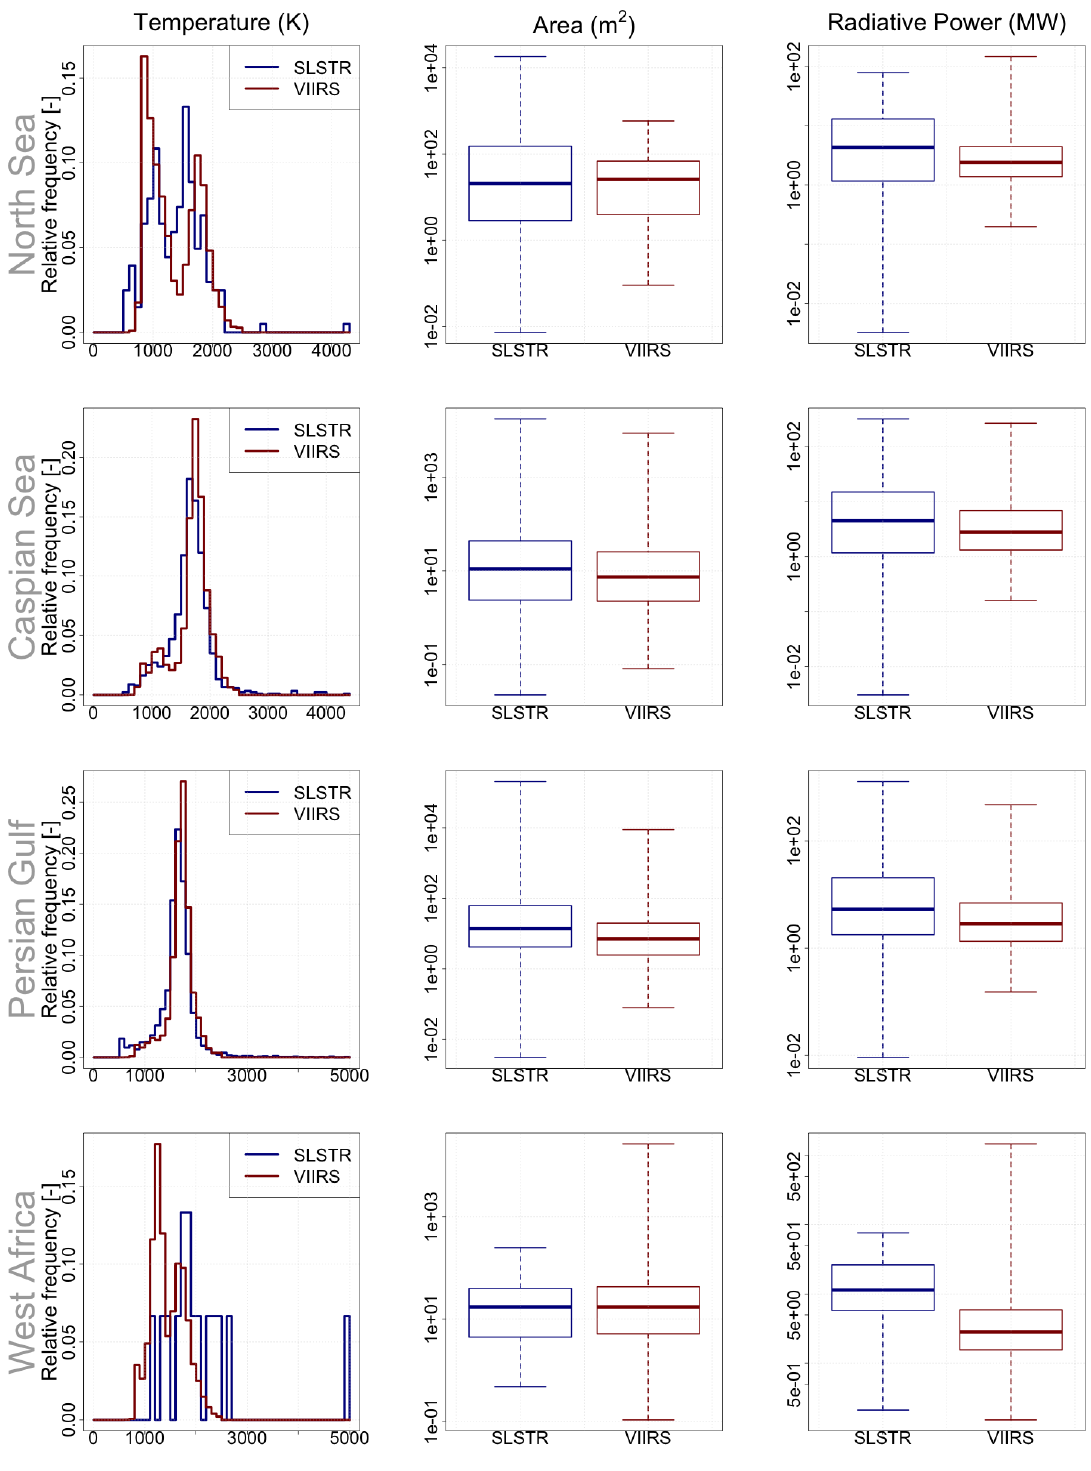
Figure 14. Comparison between temperature, area and radiative power retrieved by SLSTR and VIIRS at persistent